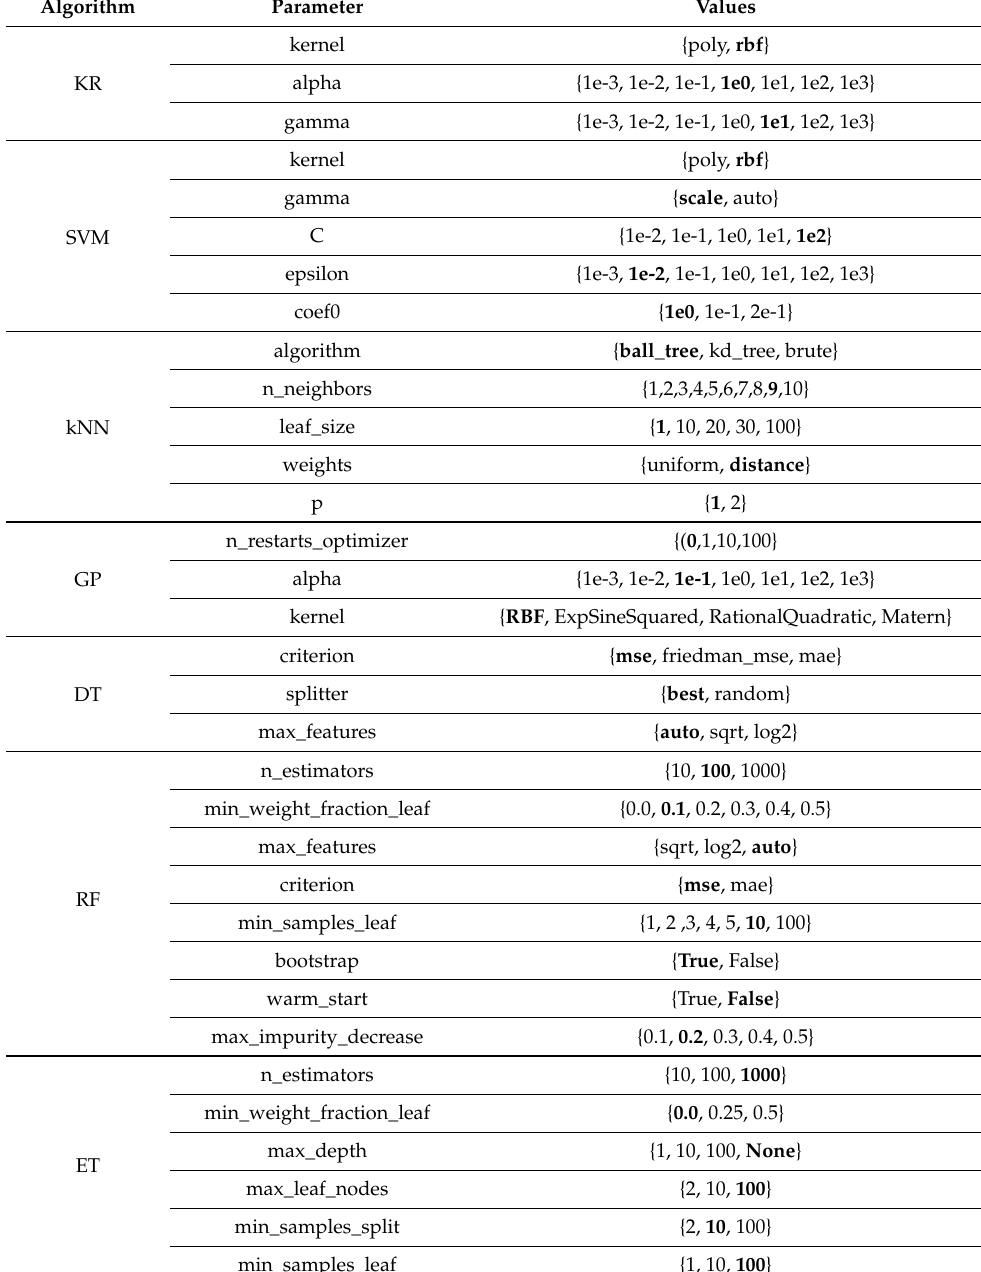
Table 2. Hyperparameters settings. The parameters in quotations refer to scikit-learn names. Optimal parameter values with respect to the considered task are indicated in bold font. Reproduced from [40] with